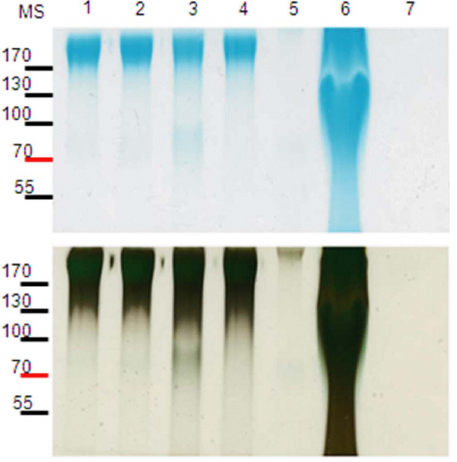
Figure 1. Staining profile and purity of polysaccharide material used for analysis. Alcian blue staining is shown on the top, and silver staining is on the bottom. Lane 1, extract from KK01 using heat; lane 2, extract from KK01 using Tris acetate; lane 3, purified material from KK01 using Tris acetate; lane 4, purified material from KK01 pamABCDE using Tris acetate; lane 5, purified material from KK01 ctrA using Tris acetate; lane 6, purified material from KK01 ctrA using surface PBS extraction; lane 7, purified material from KK01 ctrA pamABCDE using Tris acetate. MS=molecular size (in kDa).